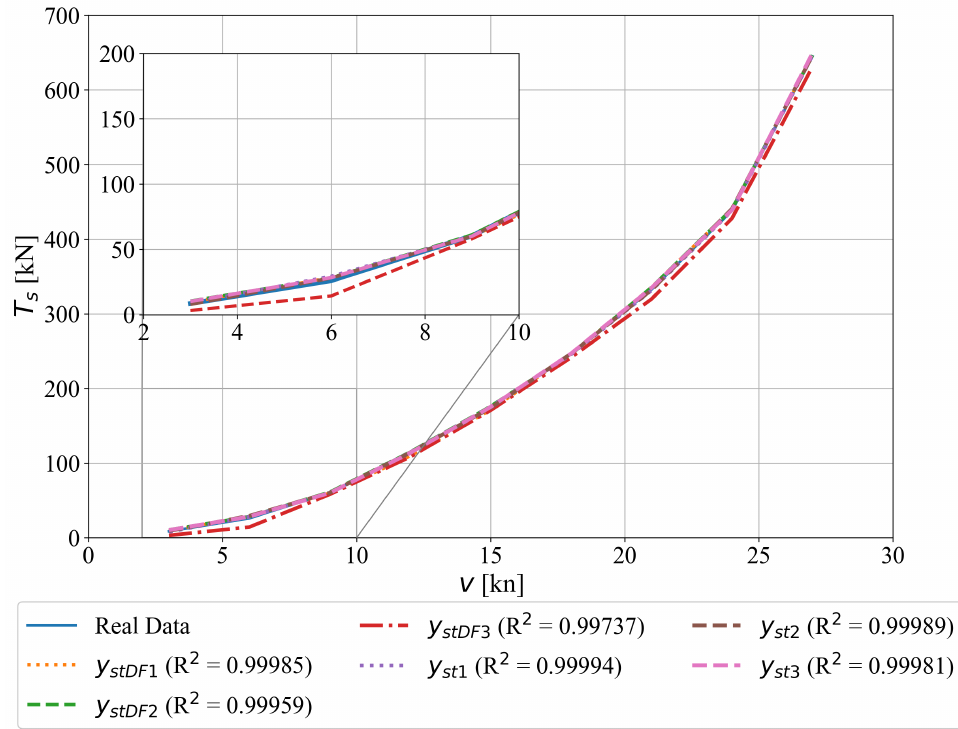
Figure 9. The Variation of Real and Estimated Starboard Propeller Torque Values versus Ship